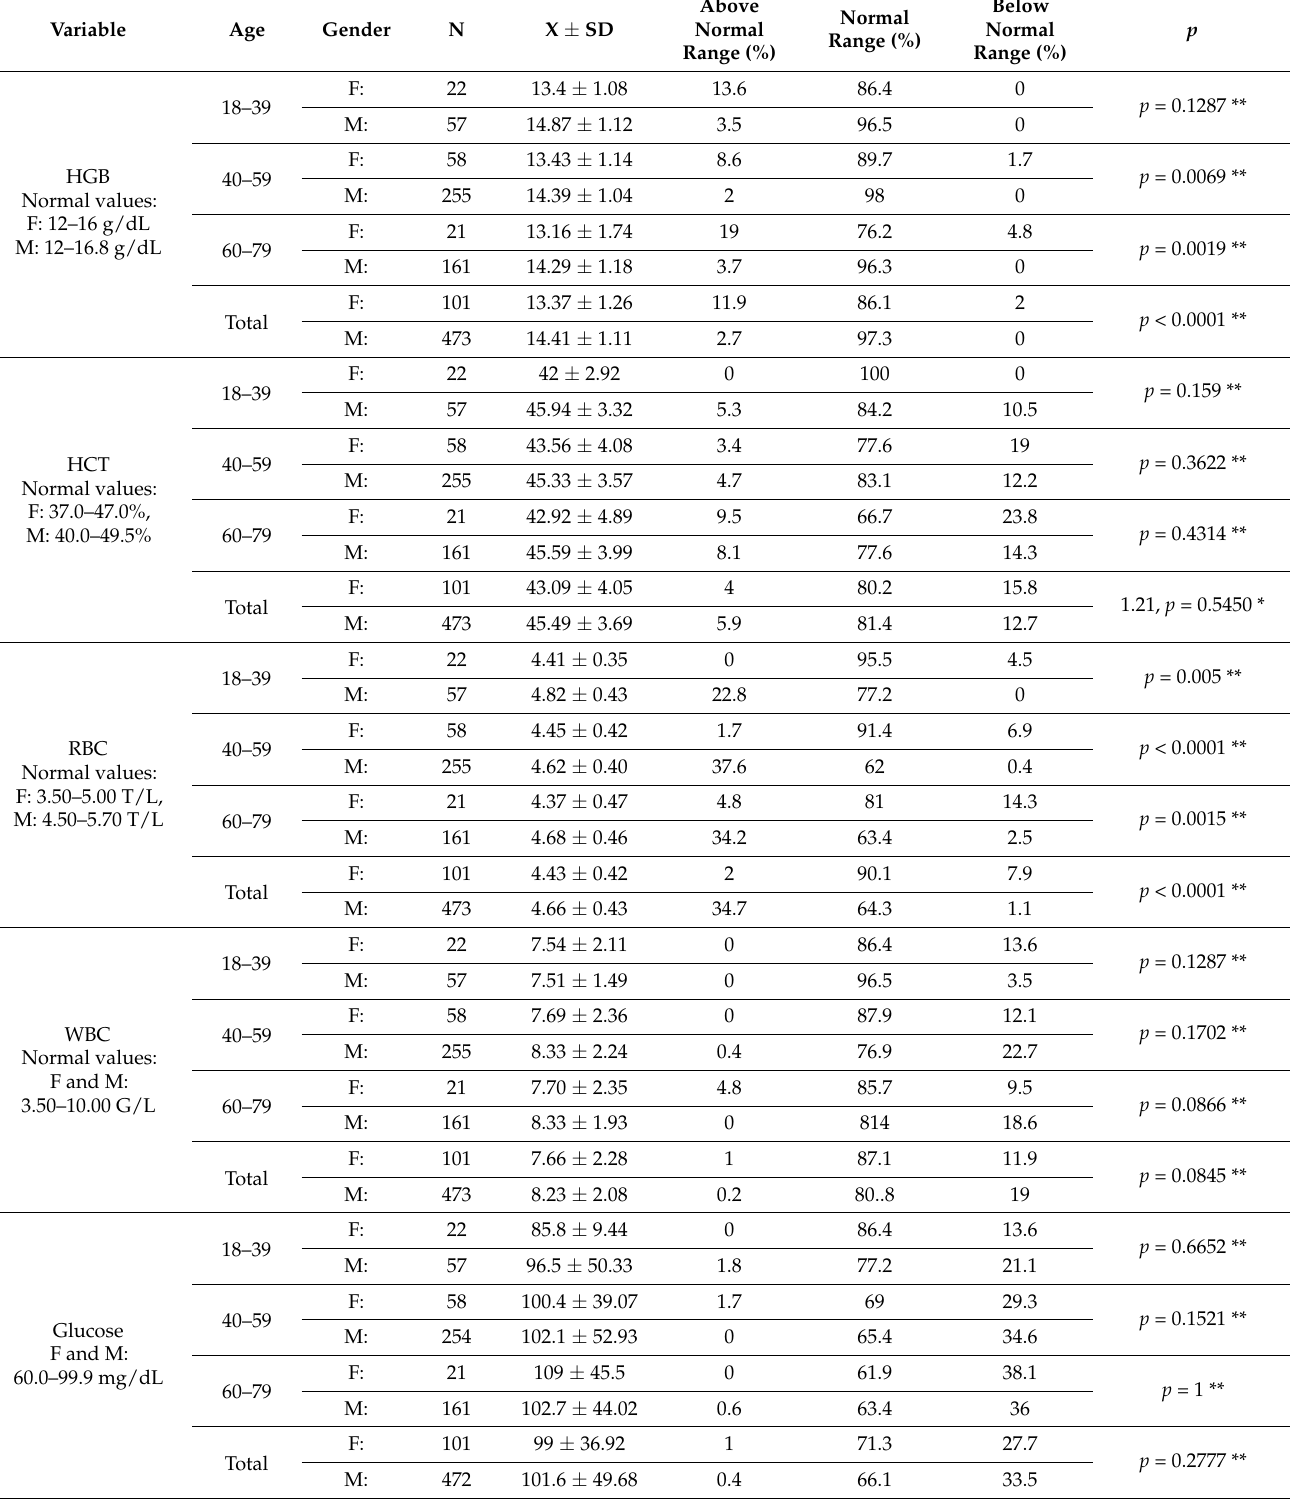
Table 4. Concentration of selected blood markers, glucose, total cholesterol, triglycerides, LDL-cholesterol, HDL-cholesterol, iron, albumin, total protein in the homeless people according to gender and age. Variable Age Gender N X ± SD